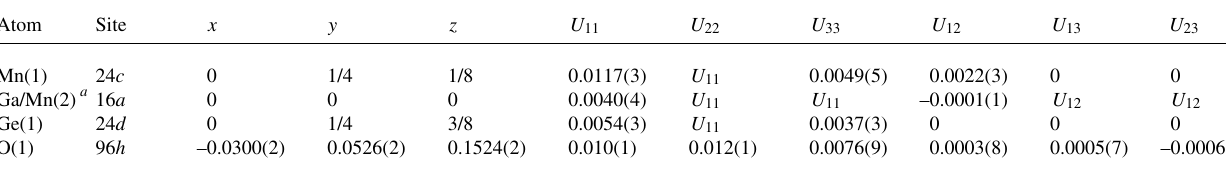
Table 4. Atomic coordinates and displacement parameters (in Å 2 ) .